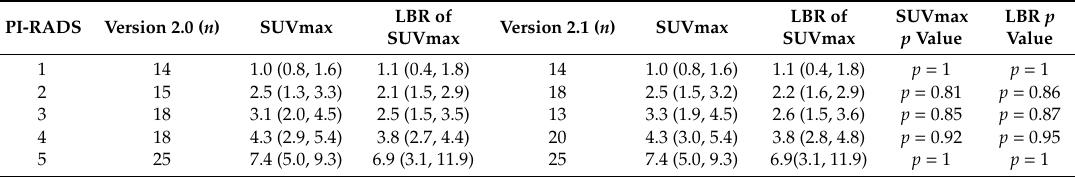
Table 3. PZ lesions SUVmax and corresponding LBR of SUVmax for Version 2.0 and 2.1. PI-RADS Version 2.0 ( n